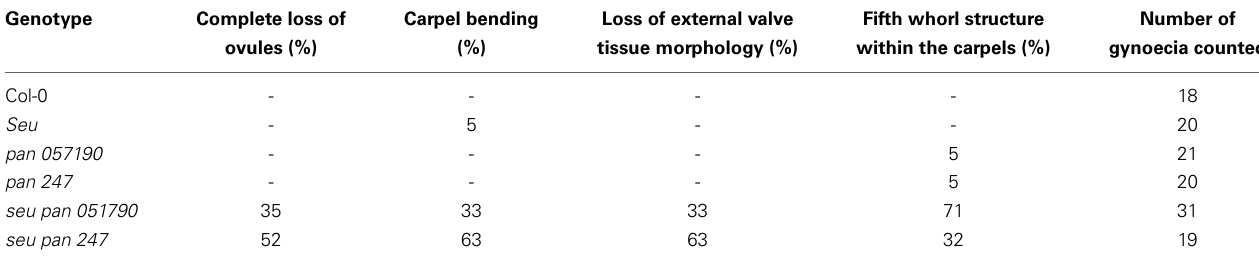
Table 2 | Gynoecial disruption in short-day grown